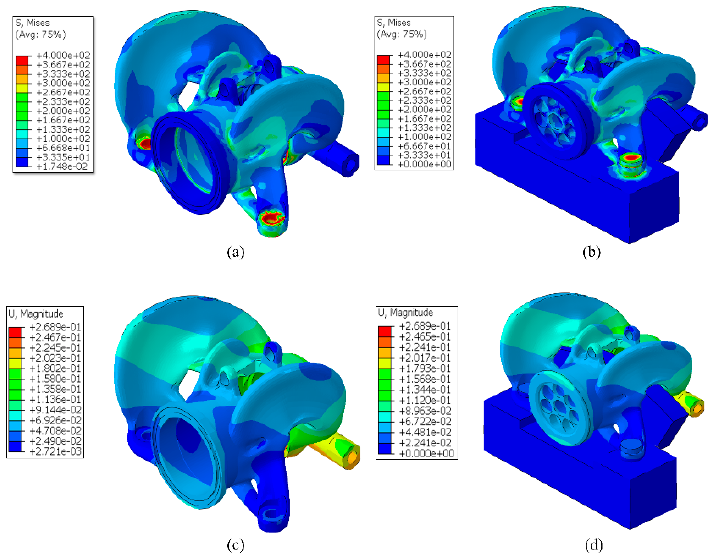
Figure 11. The results of the validation studies in ABAQUS for the front caliper: ( a ) Stress plot of the front housing, ( b ) Stress plot of the front caliper, ( c ) Total displacement of the front housing, ( d ) Total displacement of the front caliper.